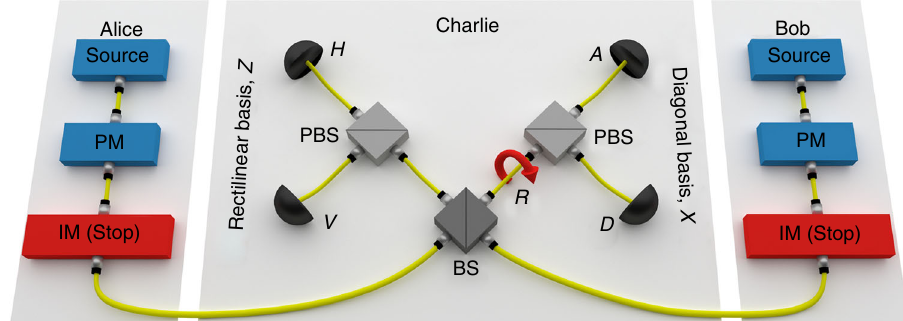
Fig. 1 Fibre-based MDI/QKD network. The key elements are coloured red. The rotator (R) in Charlie ’ s station sets each detector to measure a different polarisation state, H horizontal, V vertical, D diagonal and A anti-diagonal. The intensity modulators (IMs) can be set to high attenuation, to nearly stop the light passing through them ( “ Stop ” in the fi gure). This can enable Alice-Bob MDI-QKD, when no IM is set to Stop, or Alice-Charlie QKD, when Bob ’ s IM is set to Stop, or Bob-Charlie QKD, when Alice ’ s IM is set to Stop. At the same time, the IMs can be used to prepare decoy states 21 – 24 . PM polarisation modulation; BS beam splitter; PBS polarising beam